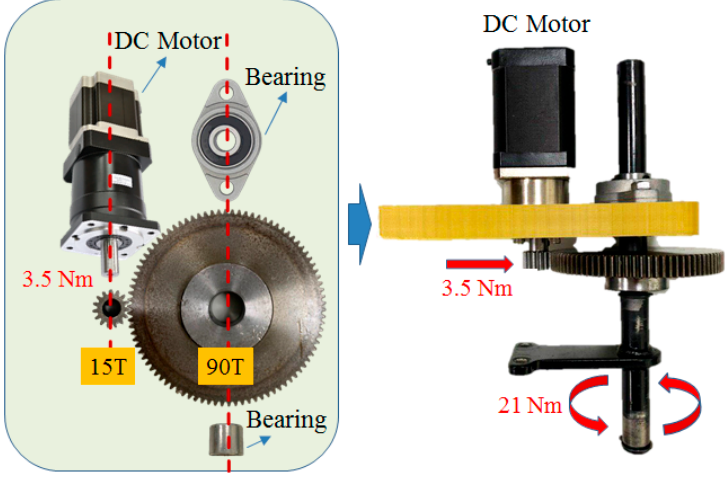
Figure 7. Mechanical design of the steer-by-wire system.